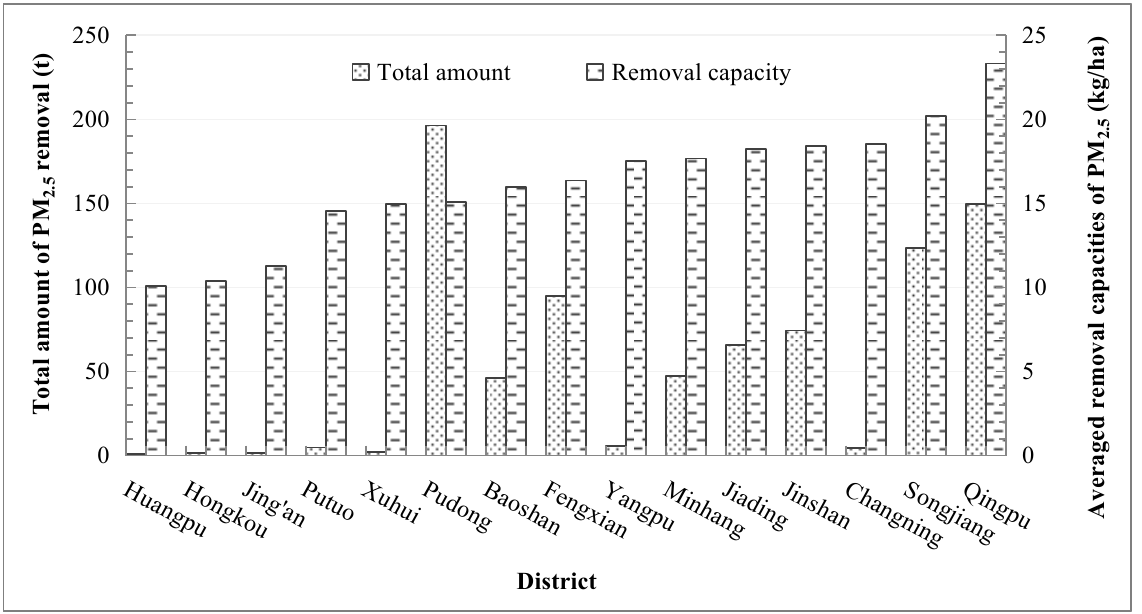
Figure 6. Estimated amount of PM2.5 removal due to urban forests of 15 districts in Shanghai.